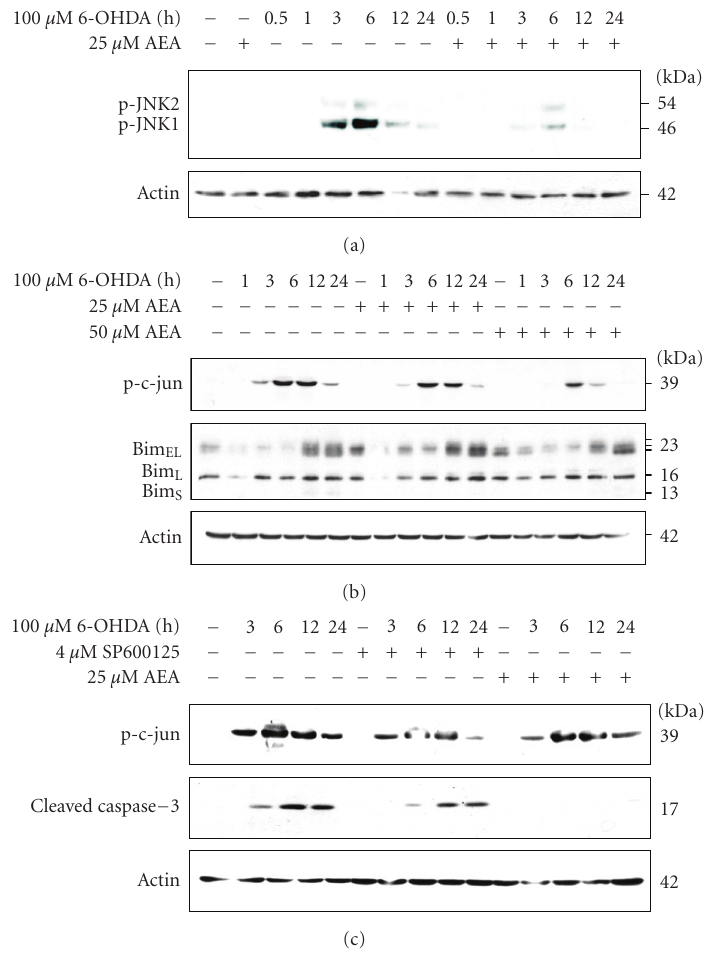
Figure 5: Anandamide partially protects against 6-OHDA-mediated apoptosis through inactivation of JNK signalling pathway. PC12 cells were treated with 25 μ M or 50 μ M anandamide for 24 hours and then exposed to 100 μ M 6-OHDA for indicated periods of time. (a) The phosphorylation state of JNK1/2 was analysed by Western blotting. Actin protein levels were also analysed as a loading control. (b) The phosphorylation state of c-Jun and Bim isoforms were analysed by Western blotting. Actin protein levels were also analysed as a loading control. Blots shown are representative of three independent experiments. (c) Where indicated, cells were exposed to 4 μ M SP600125 for 1 hour or 25 μ M AEA for 24 hour prior to treatment with 100 μ M 6-OHDA for further 24 hour. Phosphorylation of c-Jun and the processing of caspase-3 to the active 17kDa fragment subunit were analysed by Western blotting. The levels of actin expression were also determined for loading control. The data shown are representative of two separate